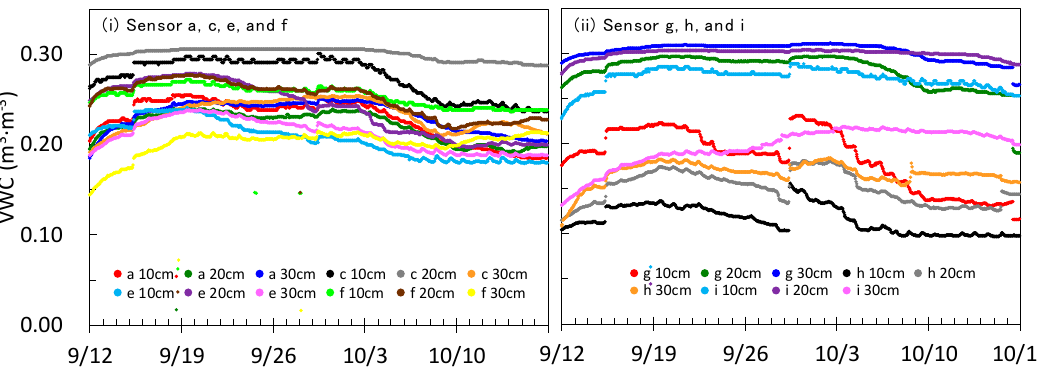
Figure 8. Volumetric water content (VWC) measured with the developed soil moisture sensors at the